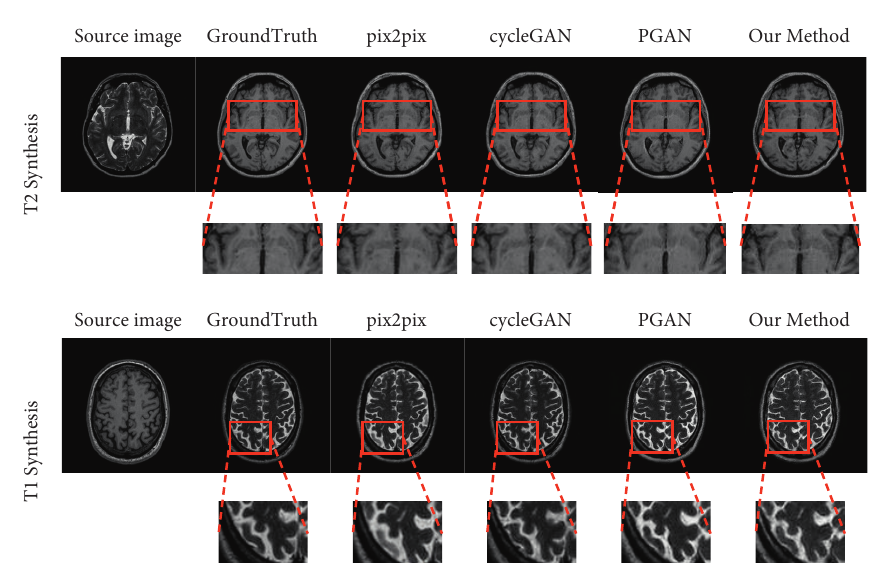
Figure 3: Synthesized images from all competing methods are shown along with the source images and the reference target image. Our method improves synthesis performance in regions that are depicted suboptimally in competing methods. Obviously, the composite images from our method have less noise and sharper tissue